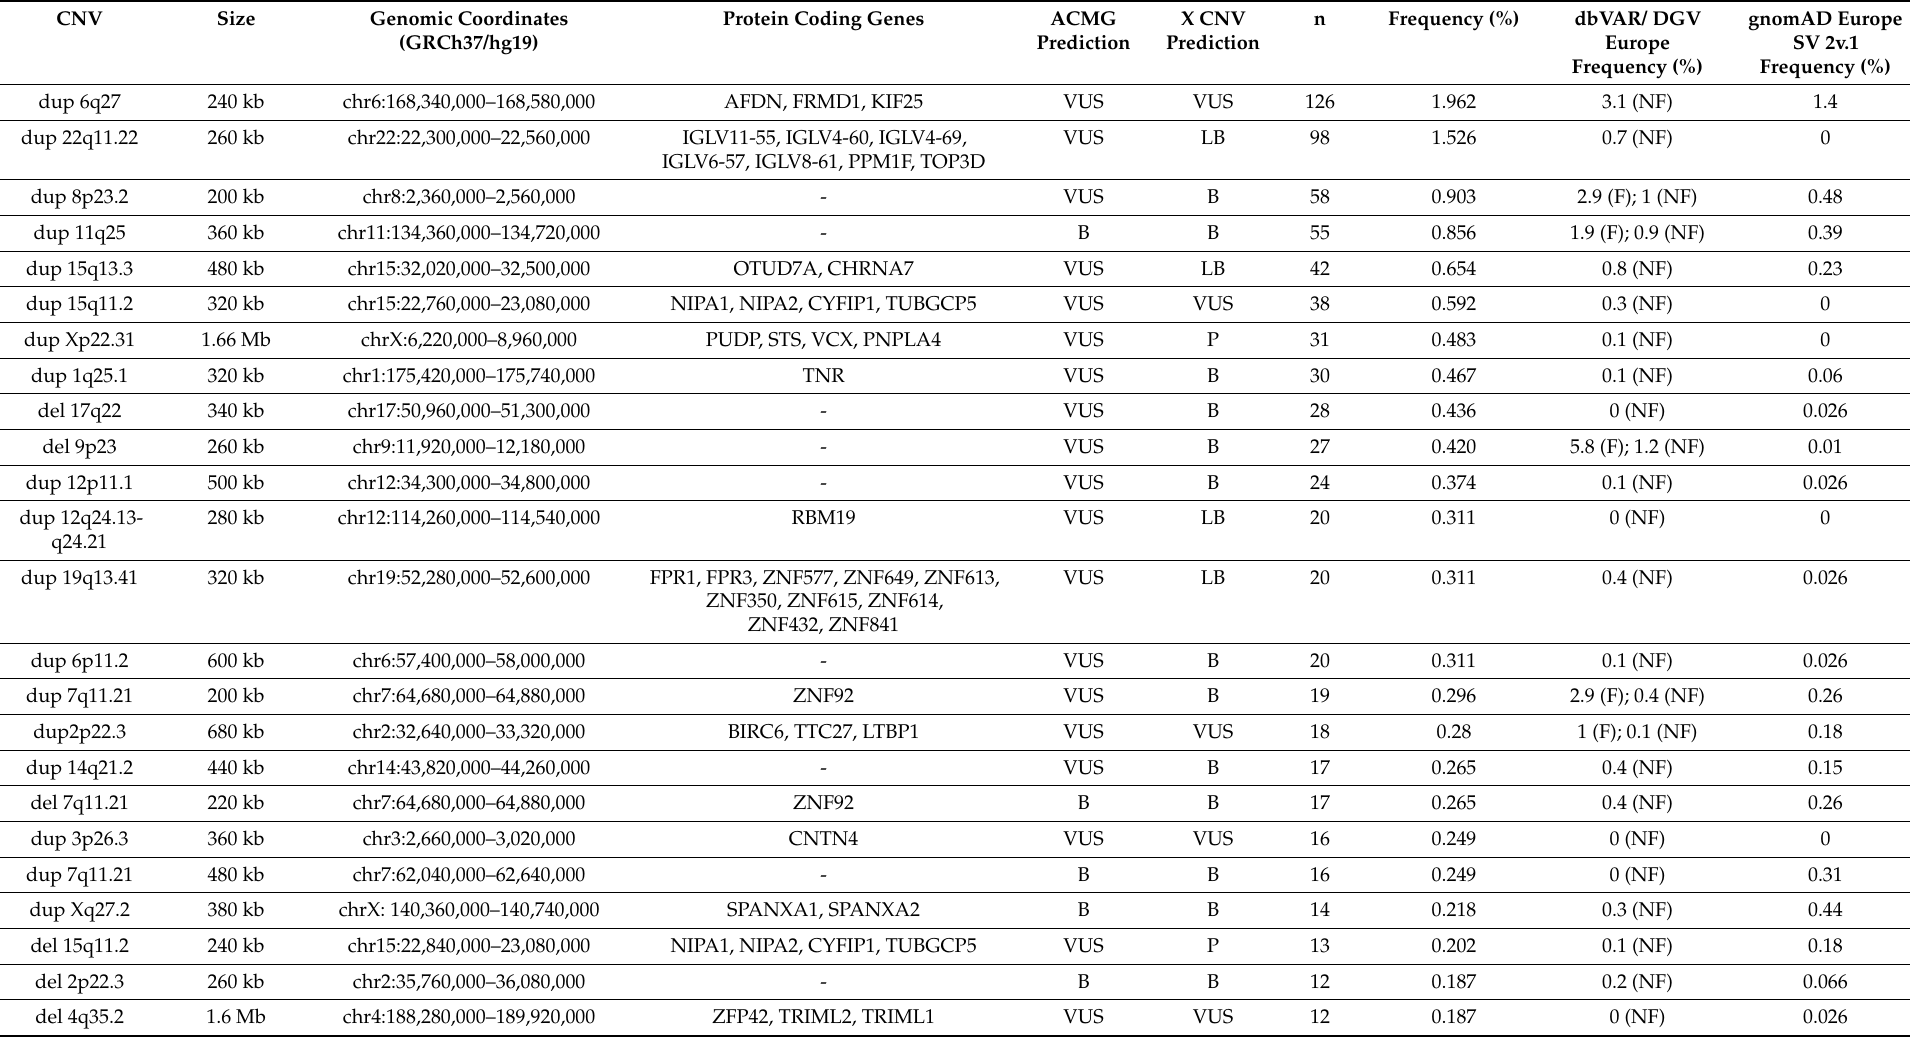
Table 1. The most frequent maternal MOVs in our cohort of NIPT